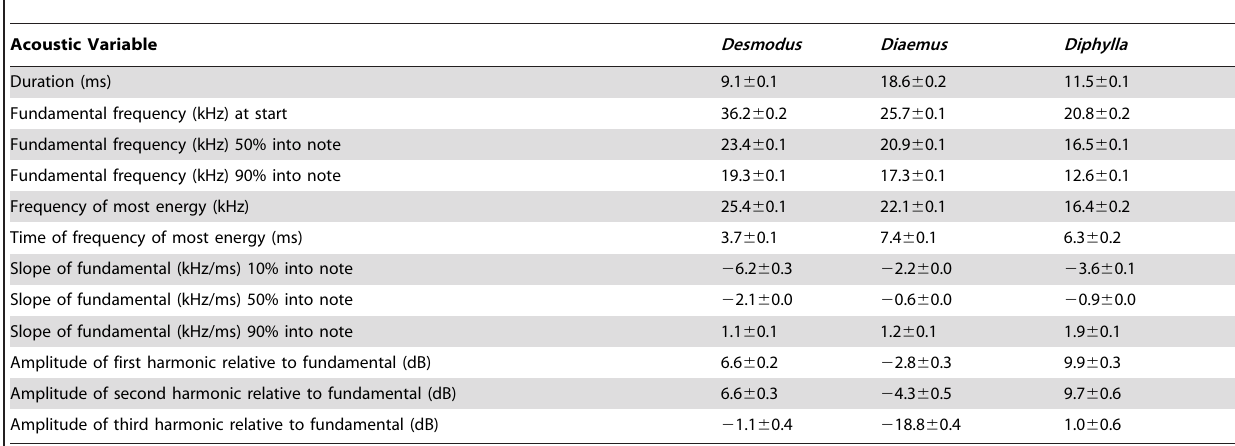
Table 3. Mean 6 standard error for 12 acoustic variables by